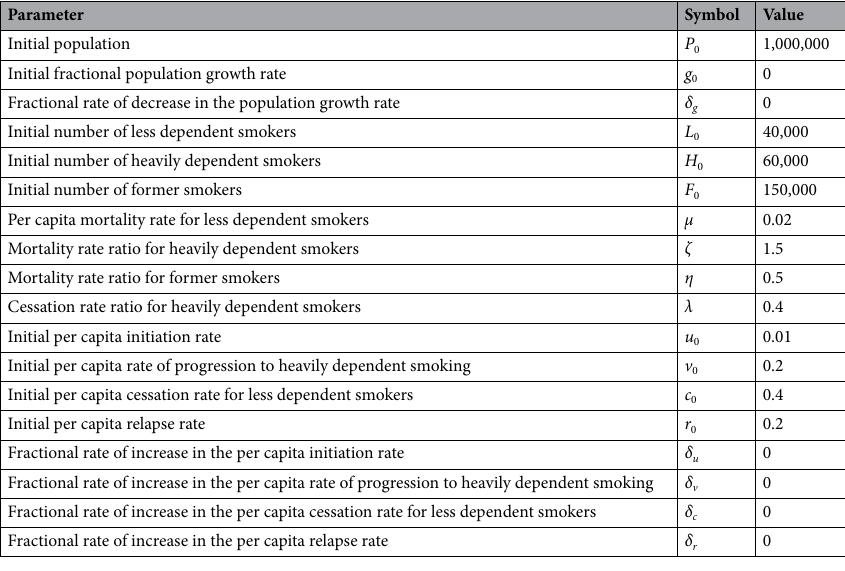
Table 1. Parameter values assumed in the simulation